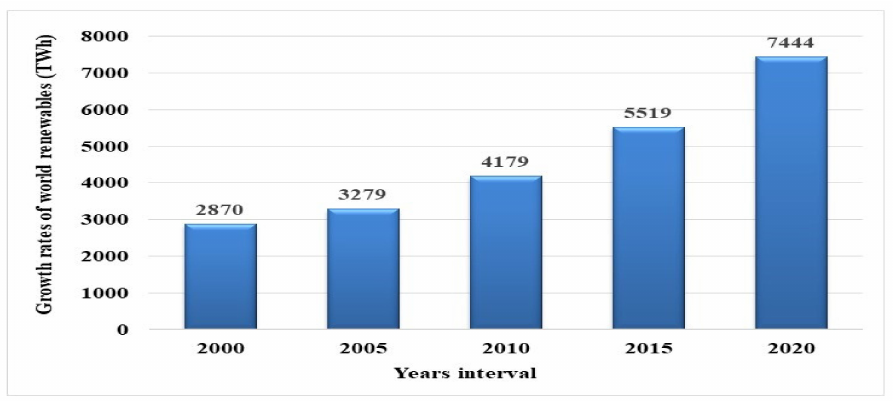
Figure 5. Average annual growth rates of world renewable supply from 2000 to 2020